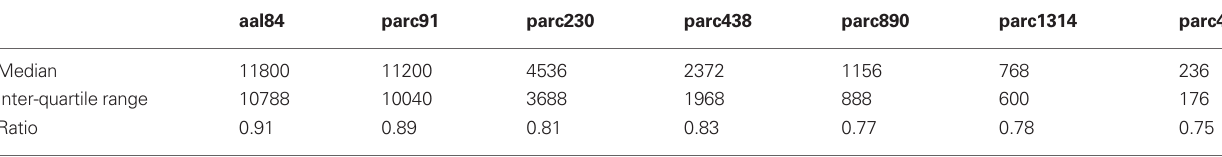
Table 1 | Region-of-interest (ROI) volume (mm 3 ) statistics as a function of parcellation